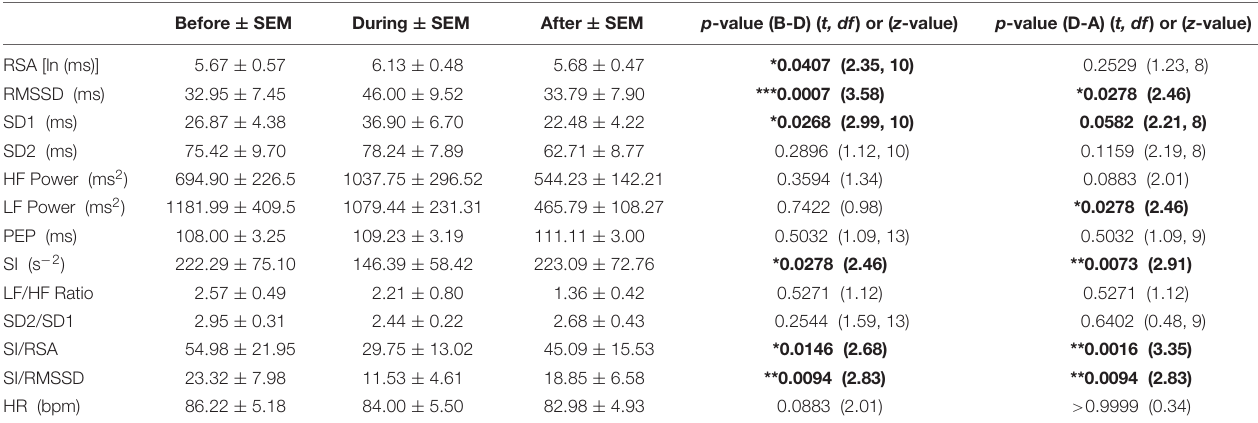
TABLE 3B | HRV parameters associated with HAPWs in response to rectal bisacodyl ( n = 11).